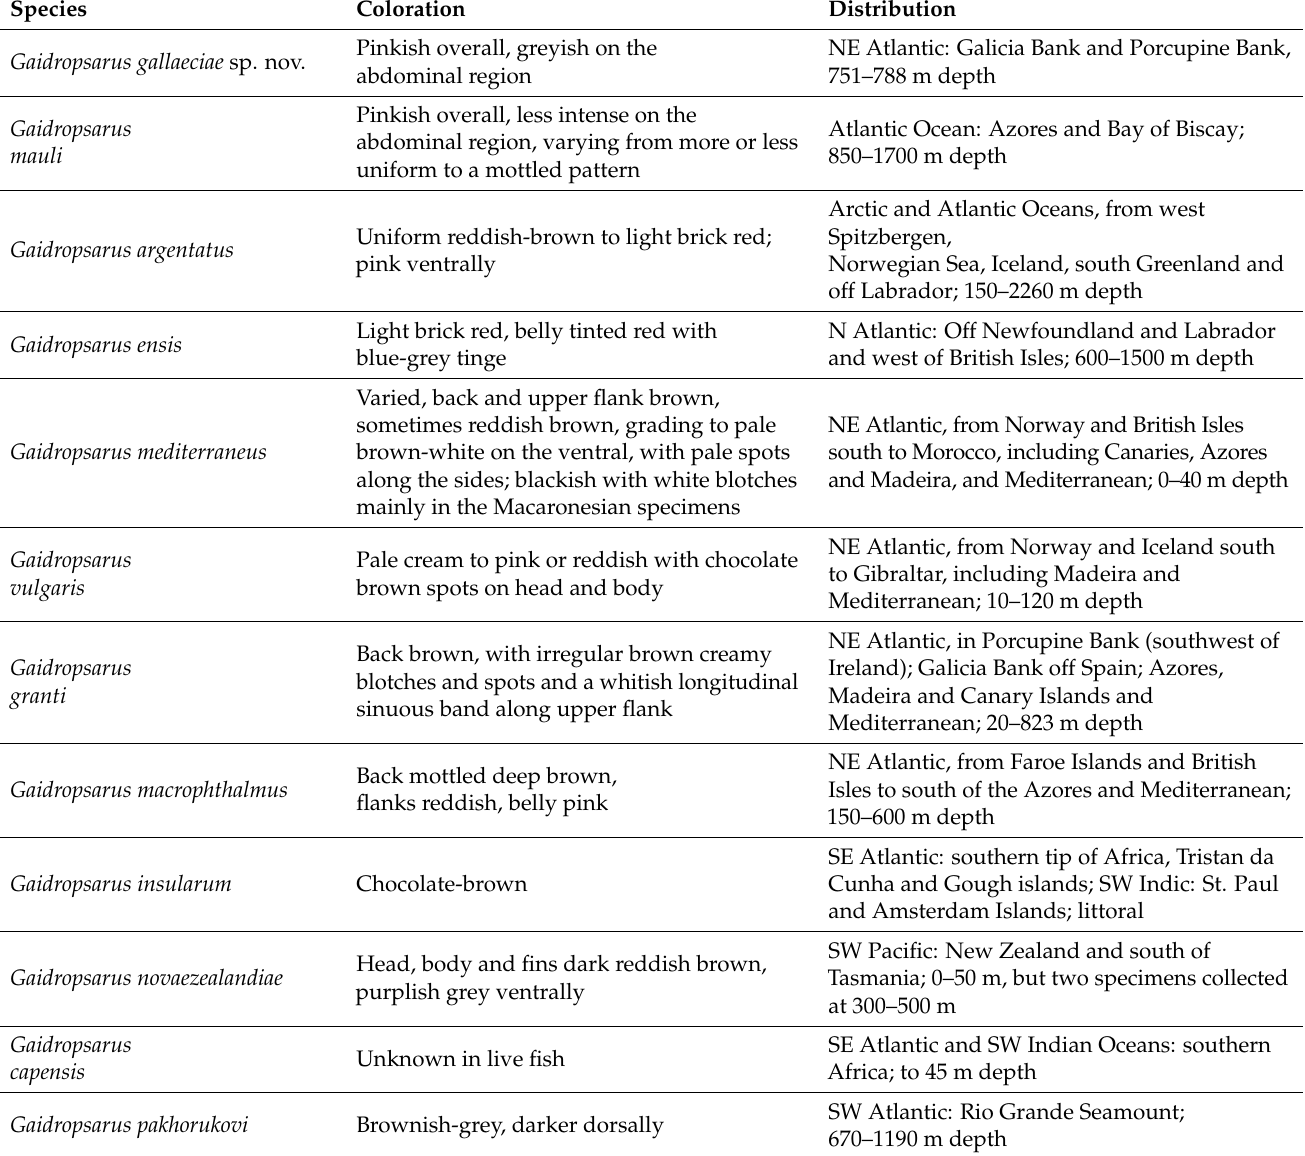
Table 3. Comparison of coloration, geographical and depth distributions between